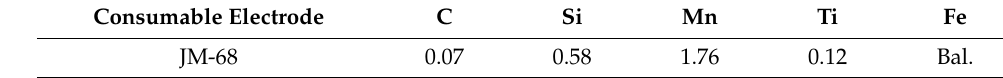
Figure 1. Schematic diagram of laser-MIG hybrid welding.